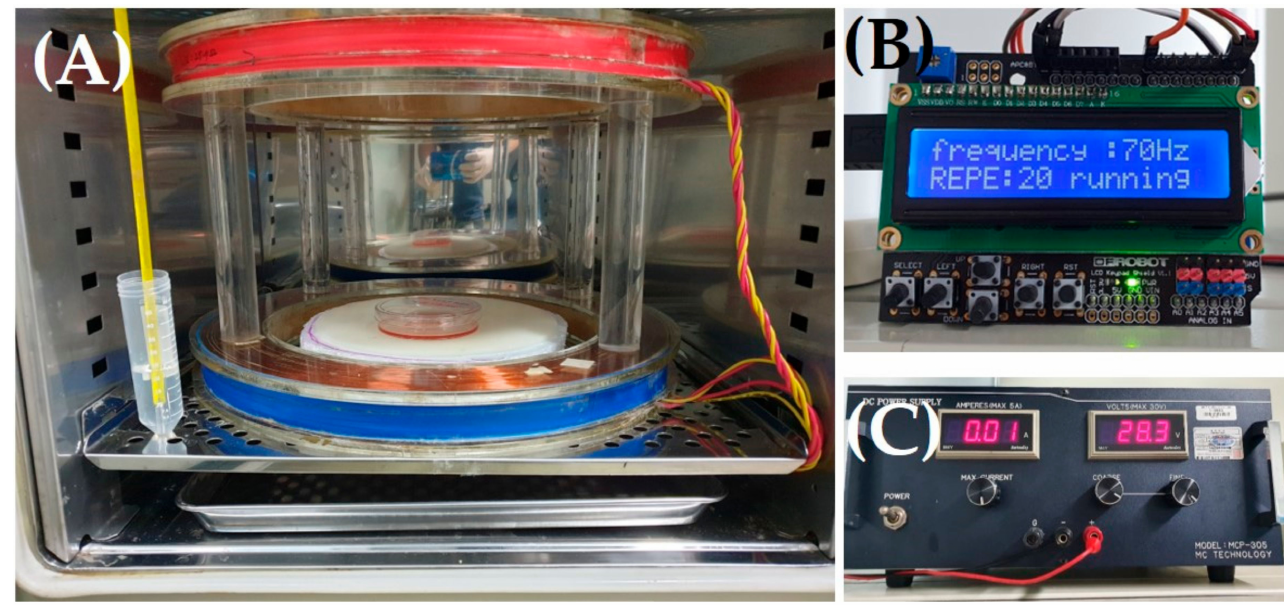
Figure 1. Image of the PEMF stimulation device. Helmholtz coils ( A ), a function generator set to 70 Hz (( B ); 40, 60, 70, and 150 Hz), and a power supply ( C ) were used. Coils were placed in an incubator (37 ◦ C, 5% CO 2 ). PEMF; pulsed electromagnetic